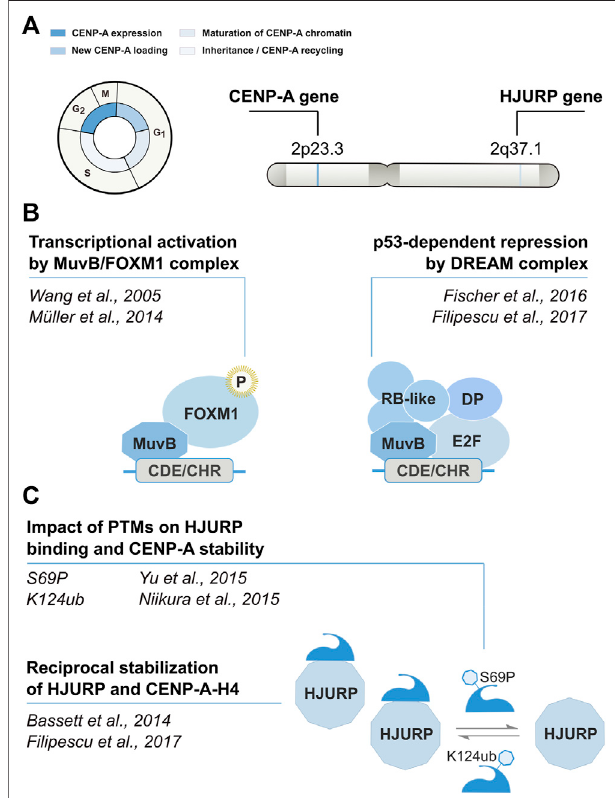
FIGURE 1 | Cell cycle timing and regulation of CENP-A. Modi fi ed from Mendiratta et al., 2019 . (A) CENP-A and its chaperone HJURP are regulated in a cell cycle – dependent manner. (B) Transcription is regulated in cis by the CHR/CDE motif in their promoter region. The recruitment of the DREAM complex at the CHR is thought to promote transcriptional repression during G1. At the beginning of S phase, the MuvB core of the DREAM complex remains bound to the CHR/CDE while other components dissociate and are replaced by B-MYB. The B-MYB-MuvB (MMB) complex recruits FOXM1 in late S phase. B-MYB is degraded upon phosphorylation, whereas the progressive phosphorylation of FOXM1 leads to its activation in G2/M. (C) CENP-A and HJURP mutually stabilize each other at the protein level. The reciprocal stabilization is affected by posttranslational modi fi cations of